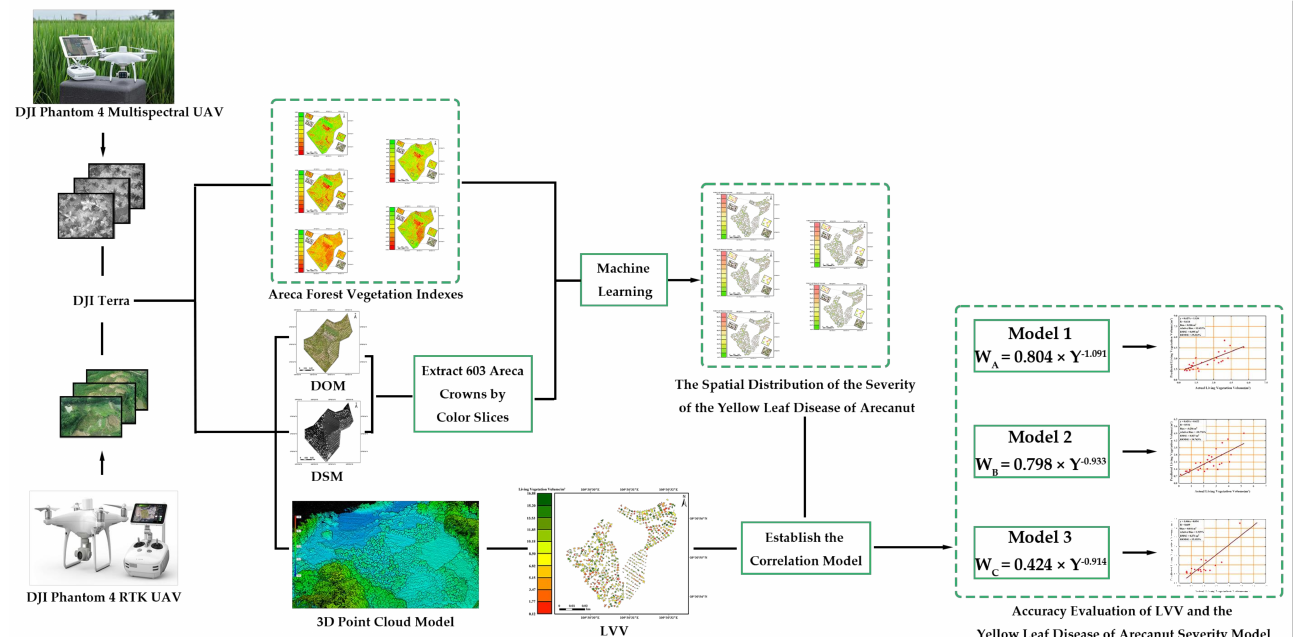
Figure 1. Technology roadmap.